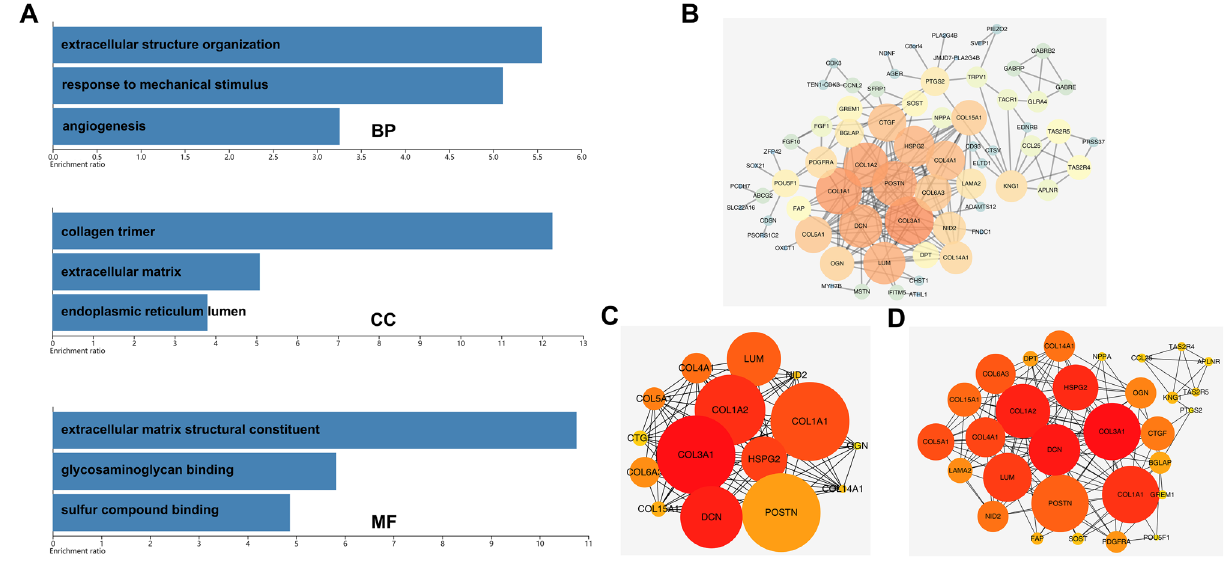
Figure 2. Function analysis on DEGs. Notes: ( A ) GO enrichment analysis of 732 DEGs, BP: biological process; CC: cell component; MF: molecular function. ( B ) PPI network of 732 DEGs after removing nodes without edges. ( C ) Top 30 nodes of PPI network. ( D ) Top 15 nodes of PPI network. GO: gene ontology; PPI: protein– protein